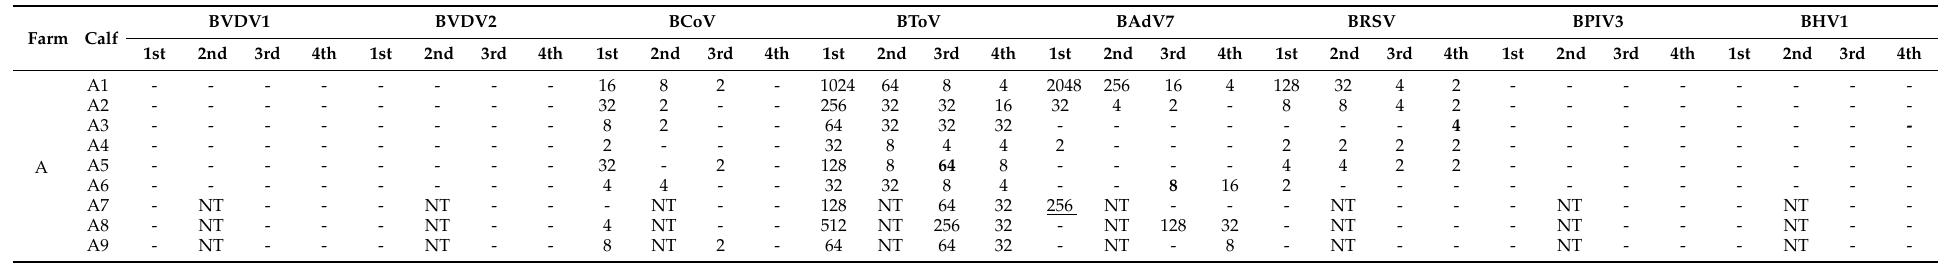
Table 3. Comparison of results by multiplex real-time RT-PCR and a significant increase in antibody titers by virus neutralization test against bovine viral diarrhea viruses (BVDV1 and BVDV2), bovine coronavirus (BCoV), bovine torovirus (BToV), bovine adenovirus (BAdV), bovine respiratory syncytial virus (BRSV),